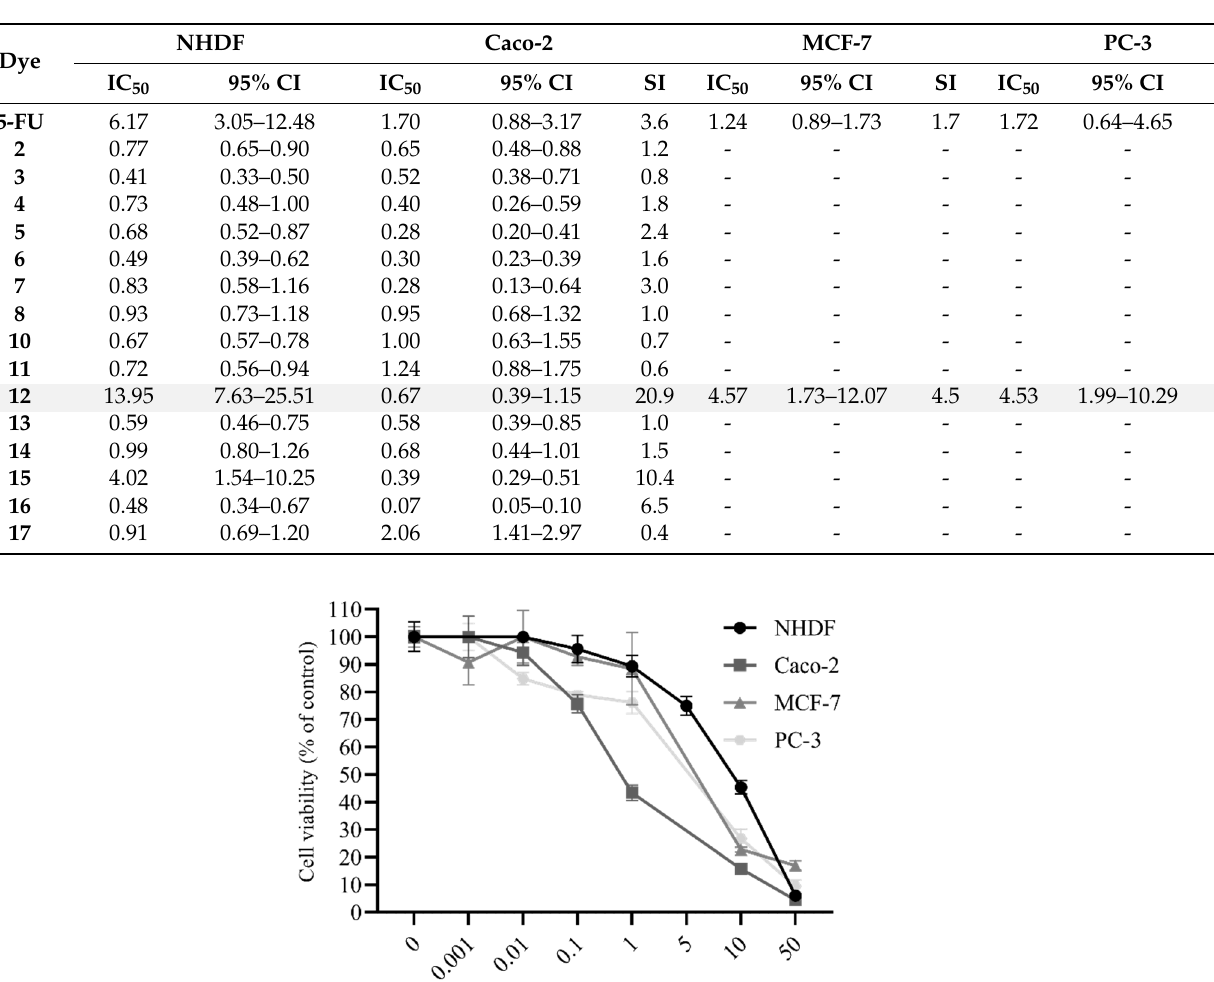
Table 2. Calculated IC 50 values, respective 95% confidence intervals (CIs), and selectivity indexes (SIs) for cancer versus NHDF cell lines of the dyes 2 – 8 and 10 – 17 and the control 5-FU on NHDF, Caco-2, MCF-7, and PC-3 cell lines after 72 h of incubation. The results are referents of at least two independent assays performed in quadruplicate.